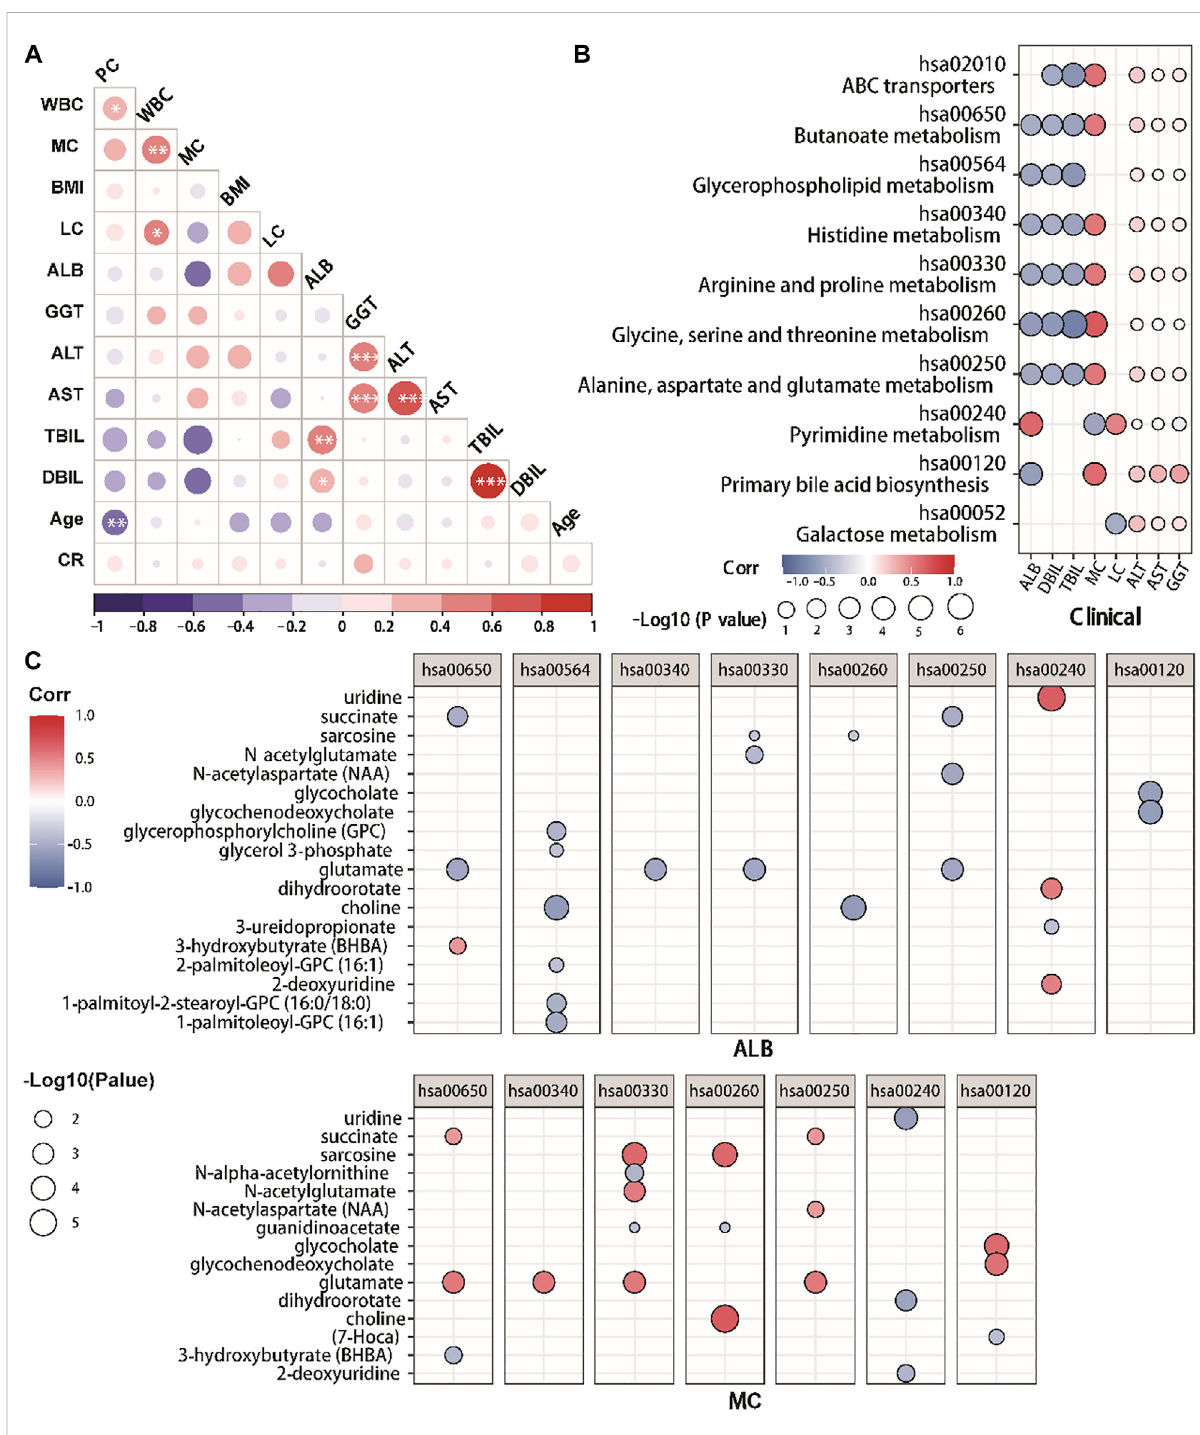
FIGURE 5 The correlation between clinical indexes and metabolites in COVID-19 patients. (A) Correlation matrix of 12 clinical features from hospitalized patients. Thecircle size corresponds to theabsolutevalueoftheSpearmanrank correlation coef fi cient, withthered(blue)colorindicating apositive (negative) correlation. p FDR < 0.05, pp FDR < 0.01, ppp FDR < 0.001. (B,C) . The altered metabolic pathways and clinical indexes correlations. (C) The alteredmetabolitesandclinicalindexescorrelations.Thecirclesizecorrespondstothe − log10( p -value)oftheSpearmanrankcorrelation.Only correlations with |R| > 0.5 and p < 0.05 were highlighted. With red (blue) color shows a positive (negative) correlation. PLC, peripheral lymphocyte